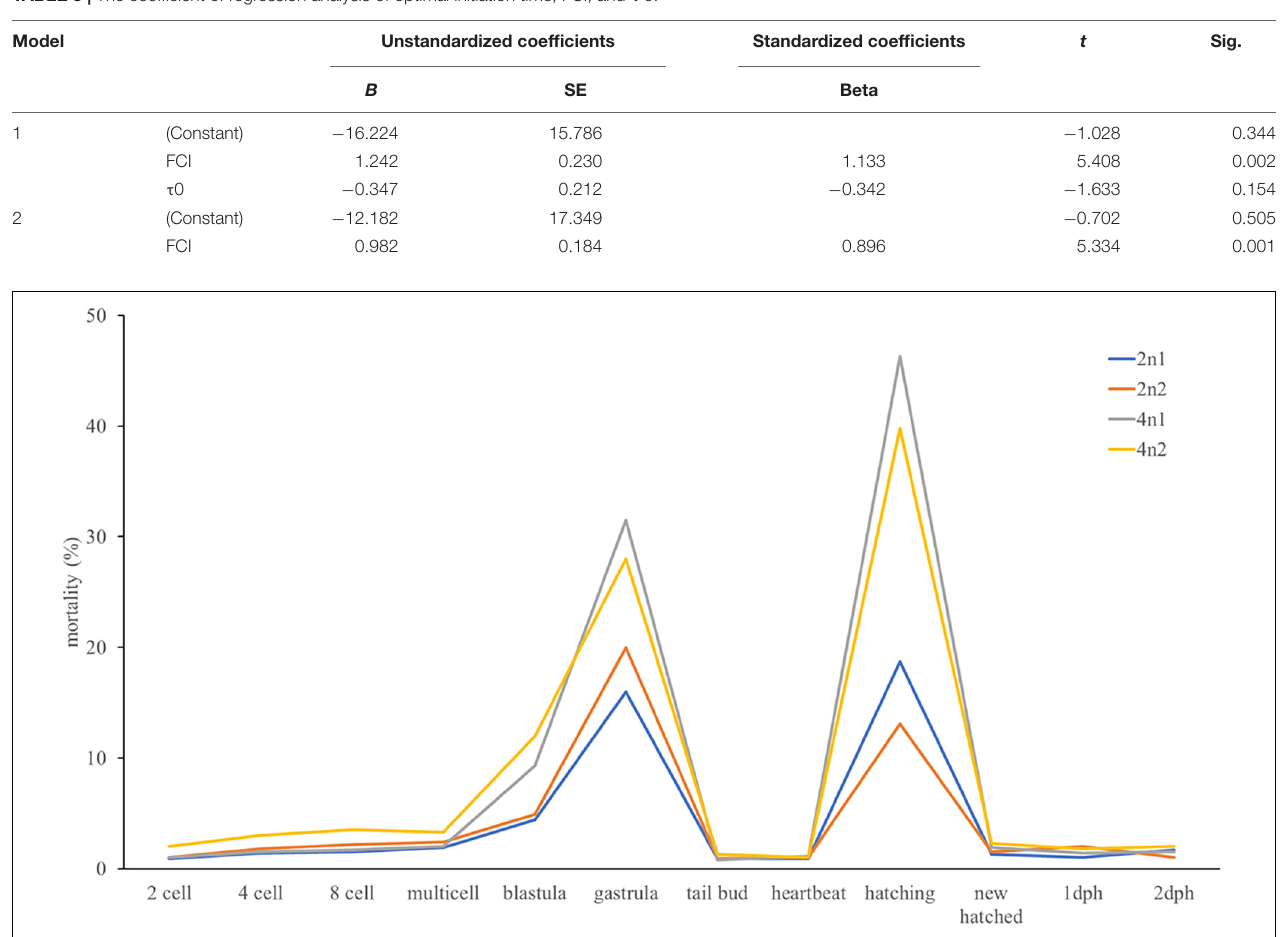
FIGURE 3 | The mortality of diploid (2n) and tetraploid induction (4n)